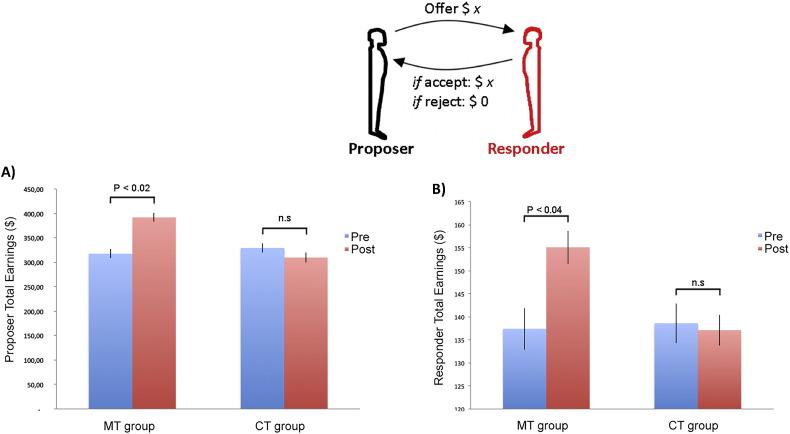
Accumulated total monetary earnings for MT and CT group across the 40 rounds of the Ultimatum Game divided into A) Proposer share and B) Responder share.A) Across all subjects the MT group increased their earnings significantly compared to pre training (paired t = 2.07; p < 0.04). The CT group did not display significant differences across the intervention. B) The proposer share also increased significantly when a proposer interacted with a subject belonging to the MT group post-training (paired t = 2.58; p < 0.02) as a opposed to the CT group (paired t = 1.6; p < 0.1).